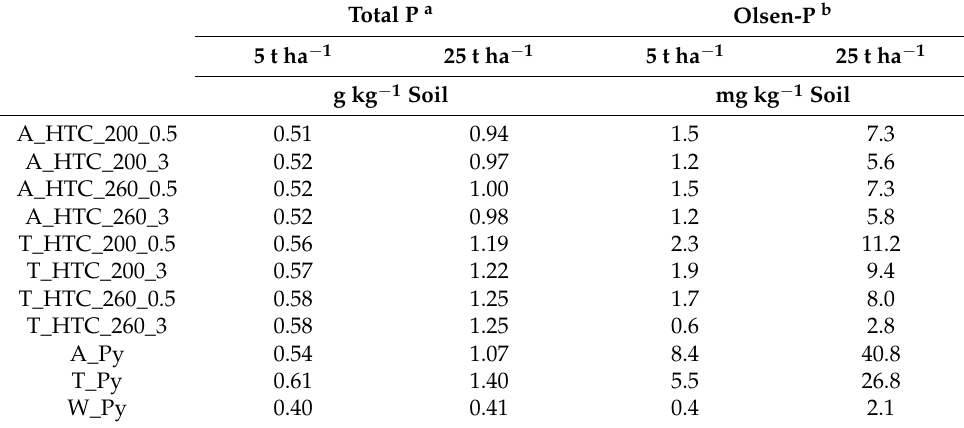
Table 3. Amount of total P (P T ) and in the soils amended with 5 and 25 t ha − 1 hydro- or pyrochar before starting the experiment and the amount of Olsen-P added with the hydrochars and pyrochars. The hydrochars were produced from primary (A) and secondary sludge (T) at 200 ◦ C and 260 ◦ C for 0.5 h and 3 h (A_HTC 200_0.5/3, A_HTC 260_0.5/3; S_HTC 200_0.5/3, T_HTC 260_0.5/3). The pyrochars A_Py and T_Py were obtained from primary and secondary sludge and W_Py from green waste. Total P